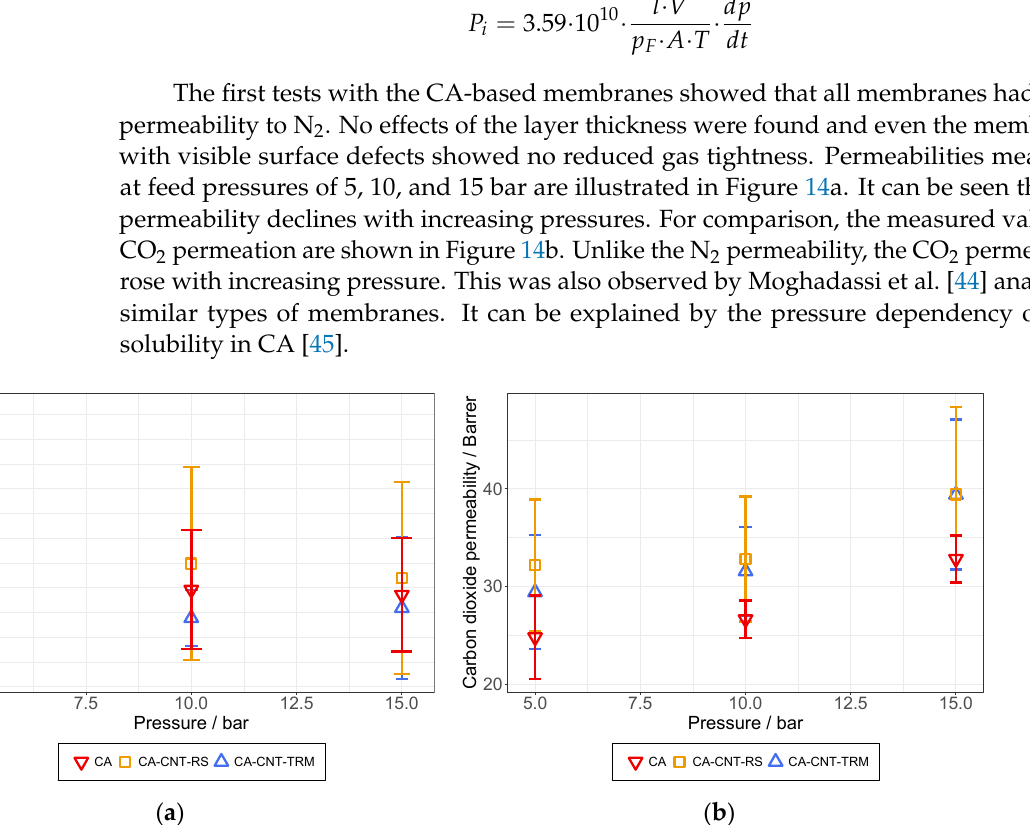
Figure 15. Selectivity of CA membranes at 5, 10, and 15 bar ( a ) and the selectivity against the per ‐ meability in dependence of the pressure 5, 10, 15, and 20 bar ( b ). For the membranes prepared from the RS dispersions, a significant deviation was found. This might be explained by aging effects, because some of the said membranes